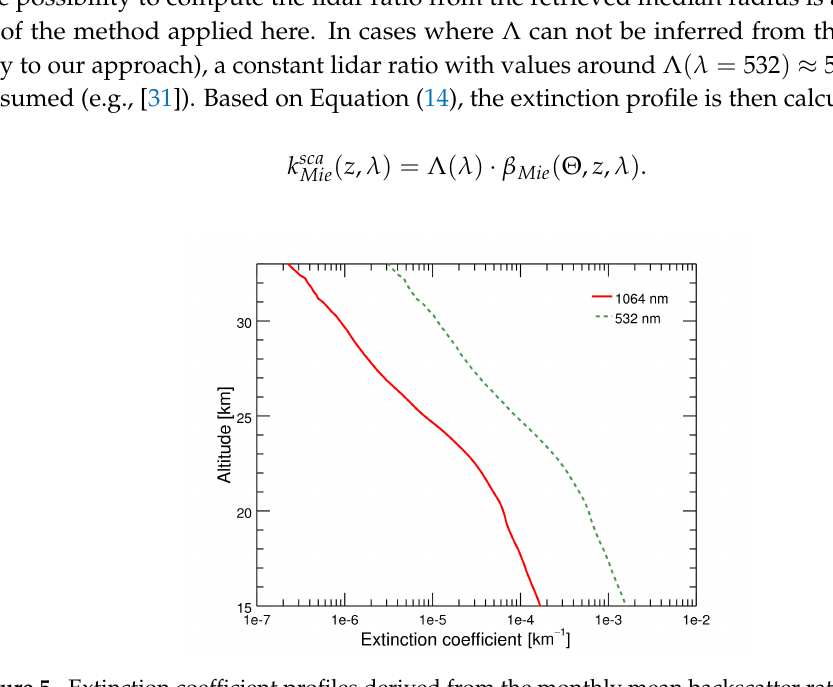
Figure 5. Extinction coefficient profiles derived from the monthly mean backscatter ratio profiles for March 2013 with an assumed distribution width of S = 1.5.